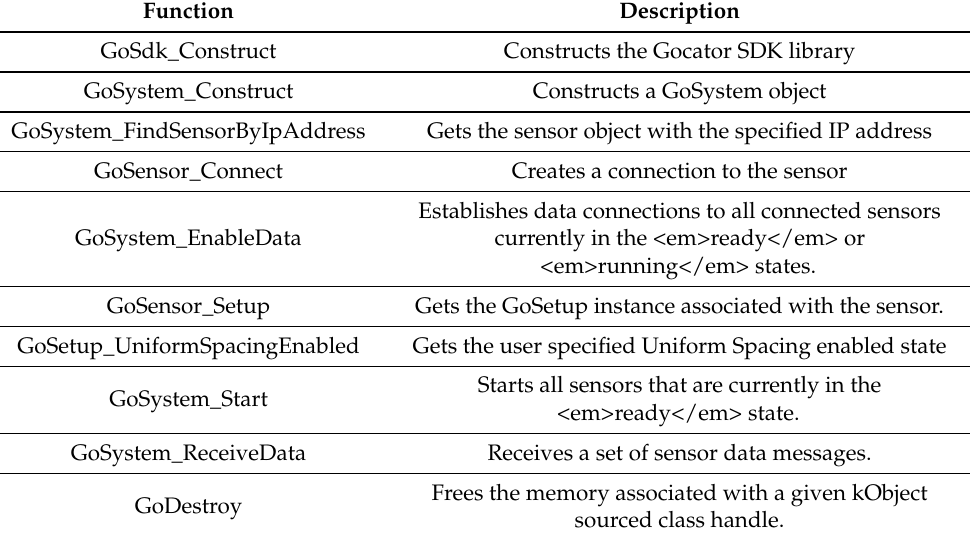
Table 1. Used GDK available functions and